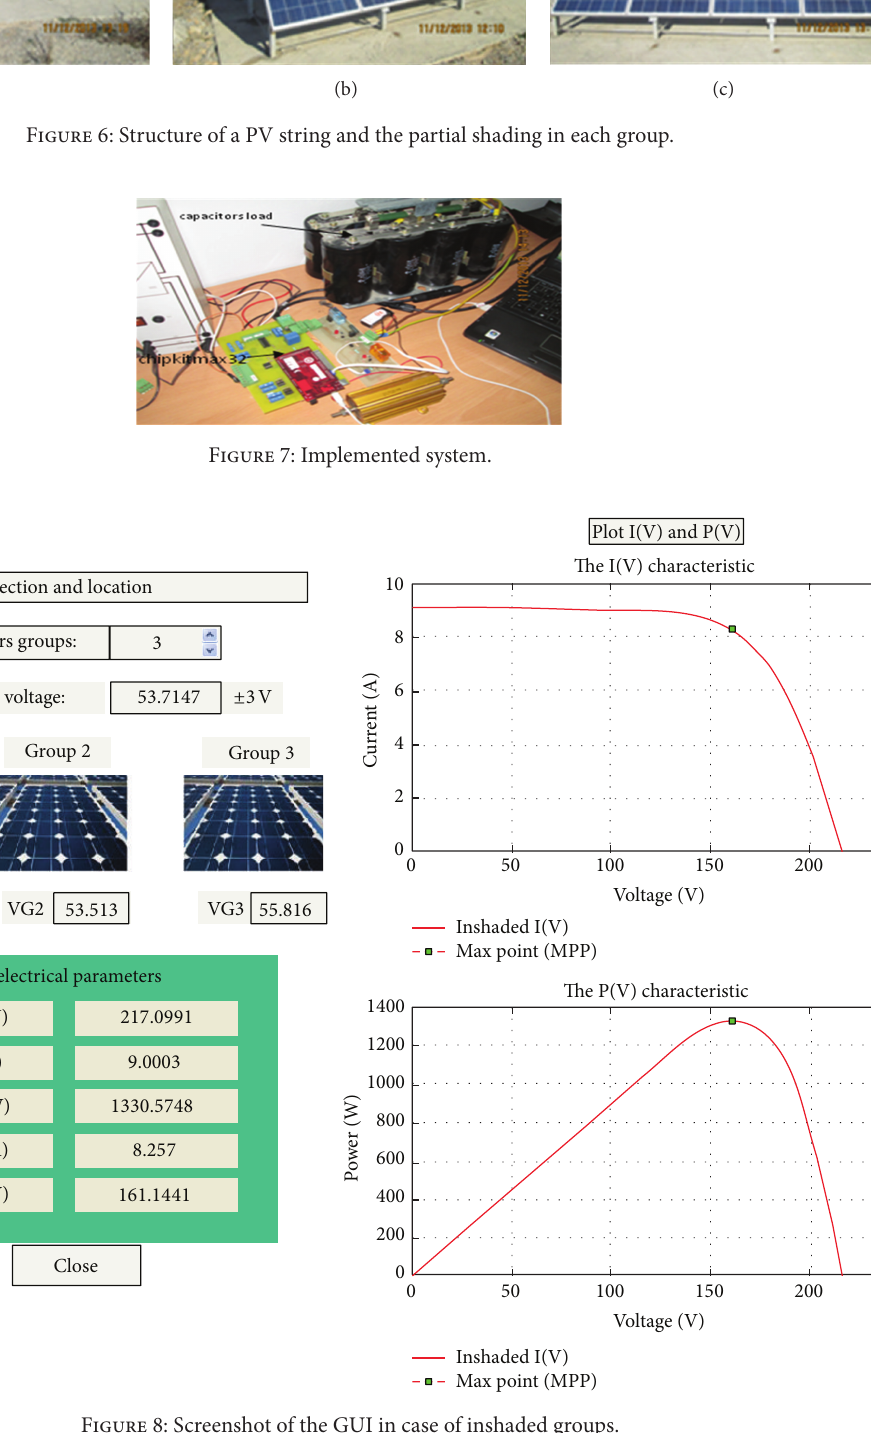
Figure 8: Screenshot of the GUI in case of inshaded